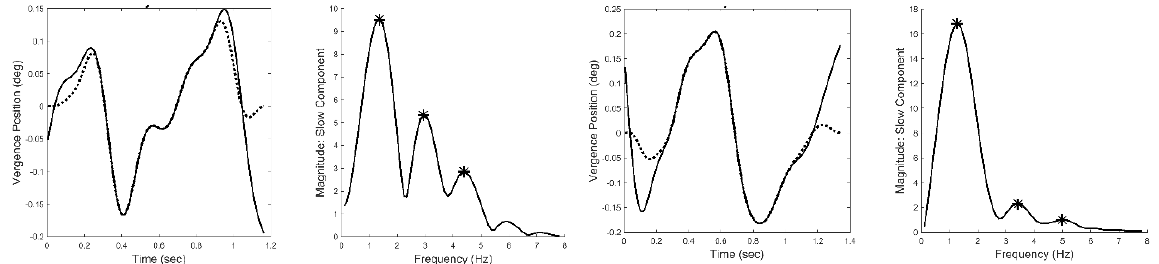
Figure 6: Two examples of isolated slow components (left-hand plots) and their associated frequency spectra (right-hand plots.) Both feature a primary, or fundamental, peak and two or more smaller peaks at higher frequencies. (Peaks are indicated by the * symbol.) This was characteristic of all responses for all subjects. Spectral differences occurred in the frequency of the peaks and the relative magnitudes of the fundamental and secondary